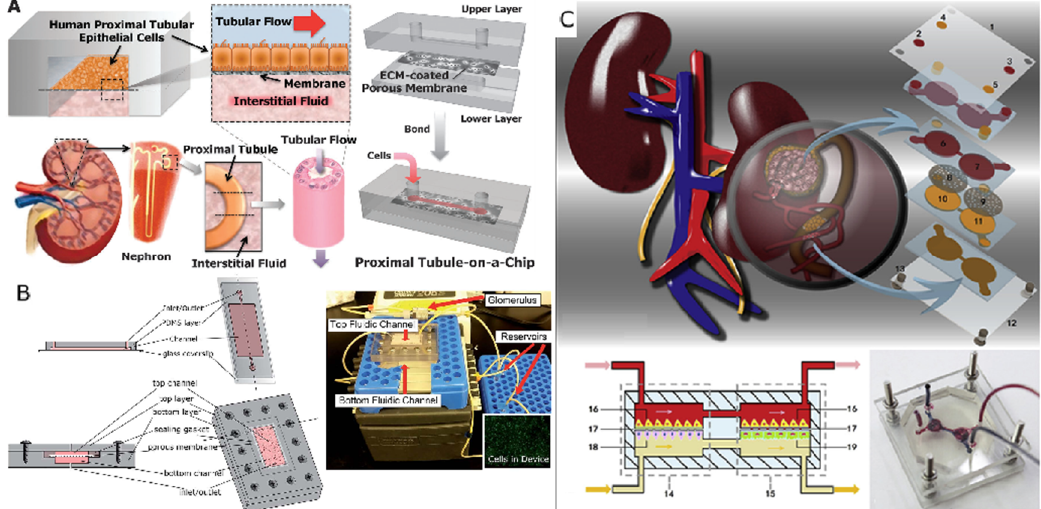
Figure 2. A kidney chip system for drug toxicity testing. ( A ) Design of the human kidney proximal tubule-on-a-chip [77]. ( B ) Microfluidic device designs for single channel and multi-channel devices, and the final device assembly with notable features marked [81]. ( C ) Design for the device contains the glomerulus, Bowman’s capsule, proximal renal lumen, and capillary tubules [86].